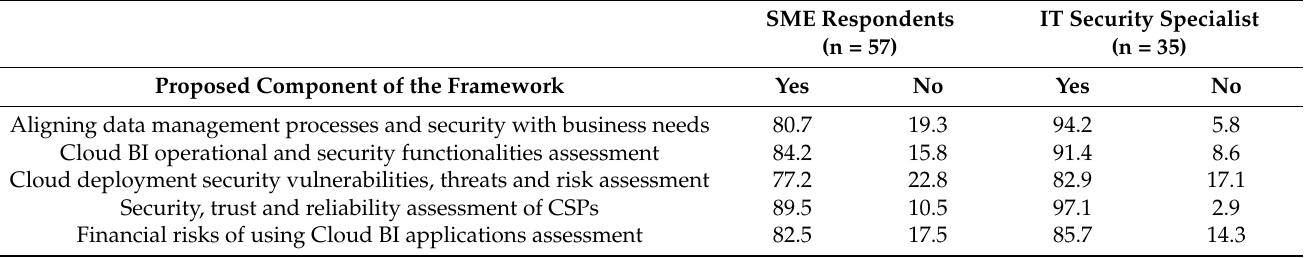
Table 5. Suitability of best practice categories as components of a security evaluation framework.